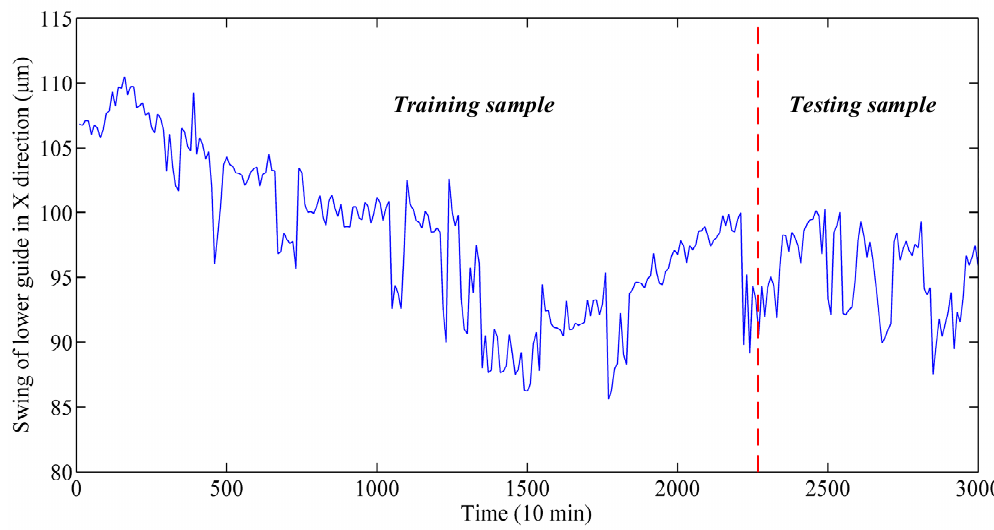
Figure 4. The swing data of lower guide in X ‐ direction.